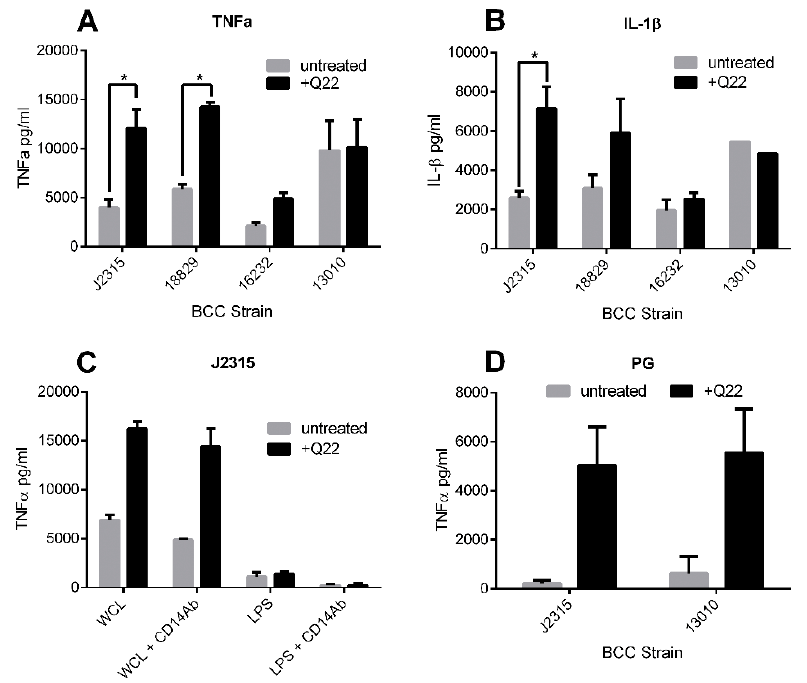
Figure 3. Cytokine responses of THP-1 cells, stimulated with Q22-treated and untreated preparations. Cytokine responses at 6 h post-stimulation with whole cell lysates of BCC strains B. cenocepacia J2315, B. cenocepacia LMG18829, B. multivorans LMG13010, and B. vietnamiensis LMG16232. ( A ) TNF α ; ( B ) IL-1 β . TNF α responses at 6 h post stimulation with whole cell lysates, purified lipopolysaccharide (LPS) ( C ), or purified peptidoglycan (PG) ( D ) from BCC strain B. cenocepacia J2315. Comparison of profiles from cells stimulated with and without a CD14 antibody pre-incubation step ( C ). * p < 0.05.